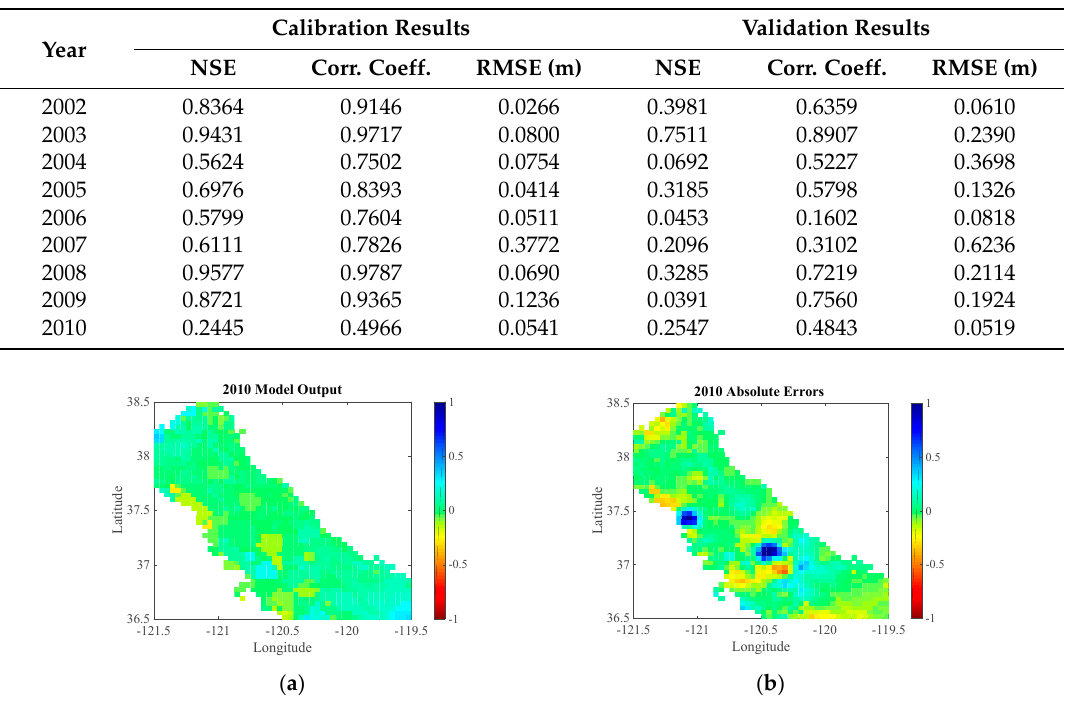
Table 2. Results of neural network downscaling approach with a kriged groundwater surface for calibration (50% calibration, 50% validation).